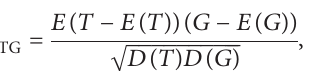
with the measurement based on DCT, DFT, KSVD, QR-CGI-OE, and XOR-LWT-